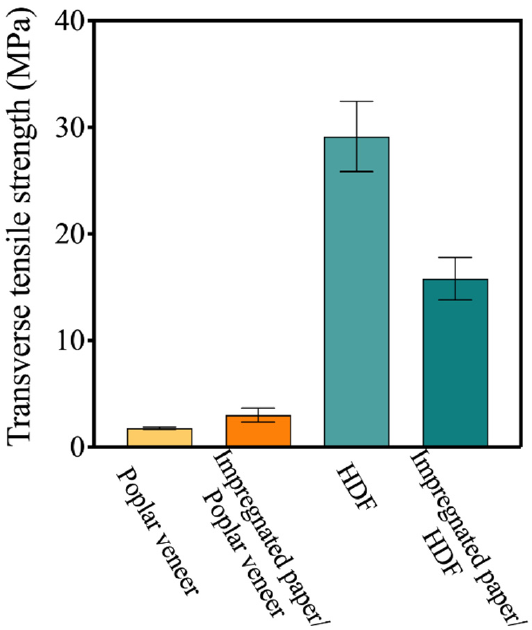
Figure 6. Transverse tensile strength of impregnated paper/equilibrium layer composites.